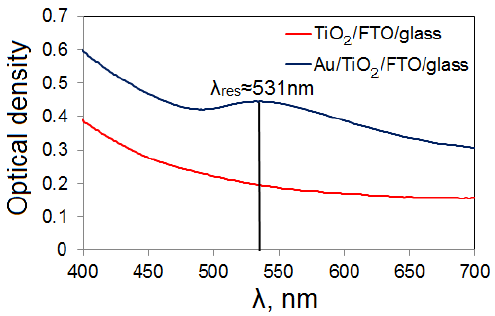
Figure 4. Optical density spectra of TiO 2 /FTO and Au/TiO 2 /FTO films. The maximum optical density for TiO 2 /FTO is 0.387 at a wavelength of 400 nm; therefore, the transmittance is 0.41. The reason for the increase in optical density with decreasing radiation wavelength is Rayleigh scattering.